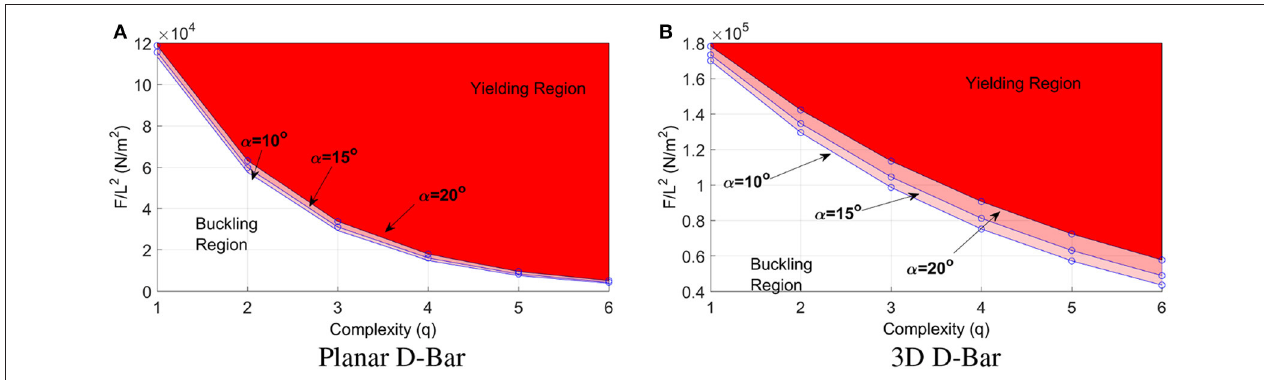
FIGURE 5 | Buckling and yielding regions with α